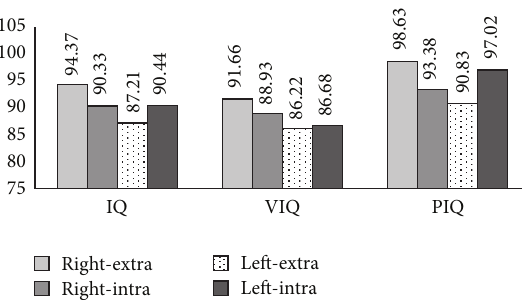
Figure 3: From pre-op WAIS scores of subgroups by detailed classifications, no significant difference was observed in IQ ( 𝐹 = .654 , 𝑃 = .583 ), VIQ ( 𝐹 = .520 , 𝑃 = .670 ), and PIQ ( 𝐹 = 1.184 , 𝑃 = .321 ) among subgroups.